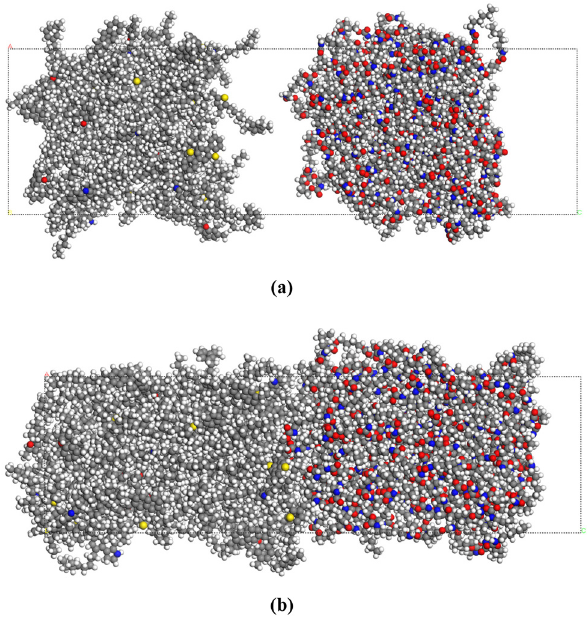
Figure 7: Interface model of asphalt and PU before and after calcu